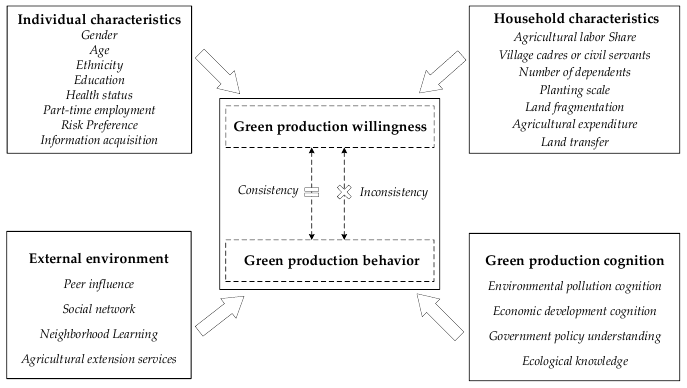
Figure 1. The conceptual framework.